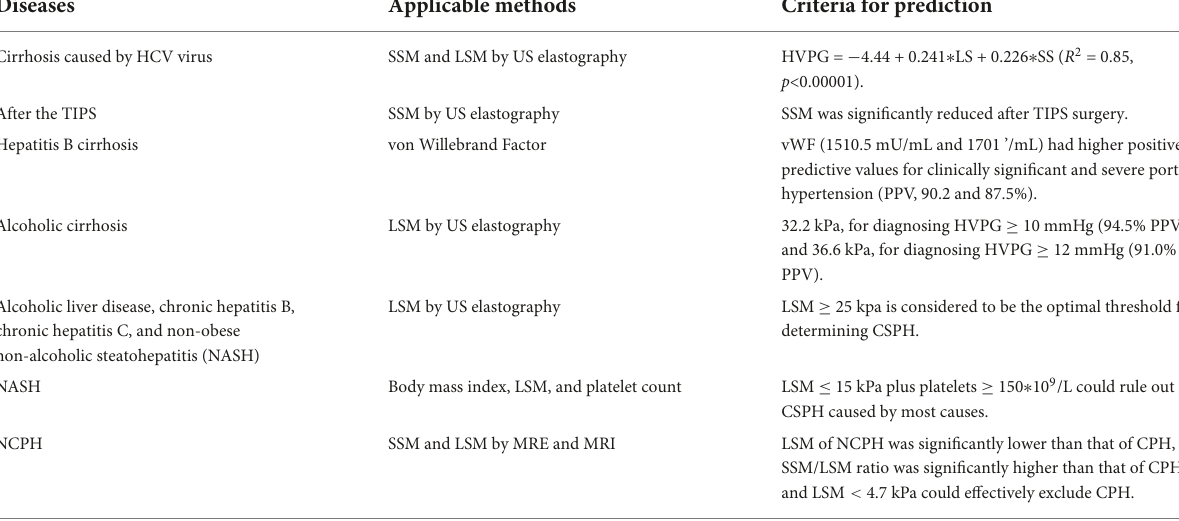
TABLE 9 Screening criteria and prediction models for different types of diseases.